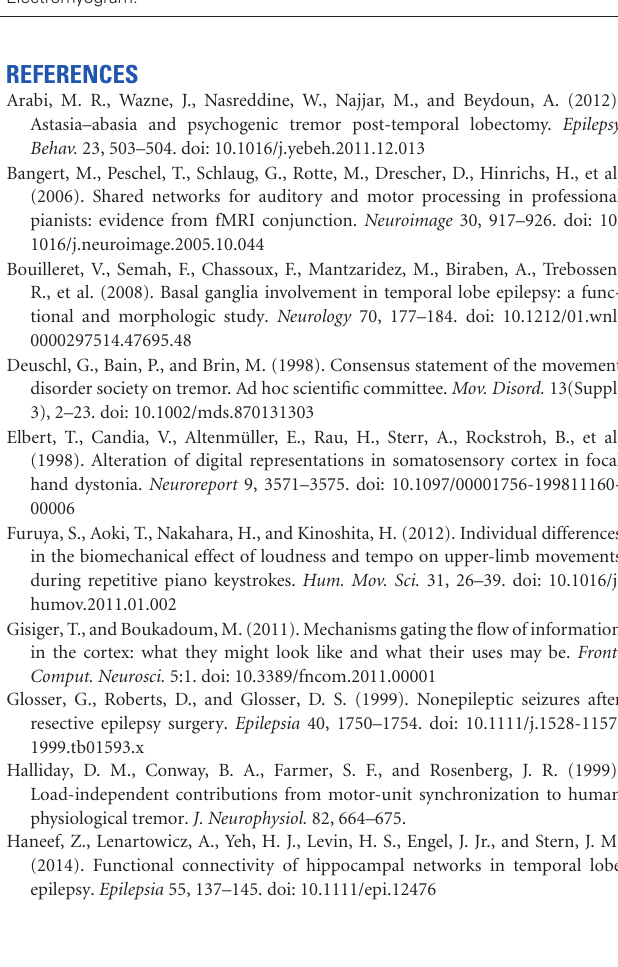
FIGURE 2 | (A) Fourier Transform (FFT) of the Electromyogram (EMG)-activity of the wrist flexor and extensor and the coactivation of the right arm. A peak-frequency of about 7 Hz is visible. (B) Coherence between EMG-activity for the wrist flexor and extensor and the accelerometer-signal (upper two